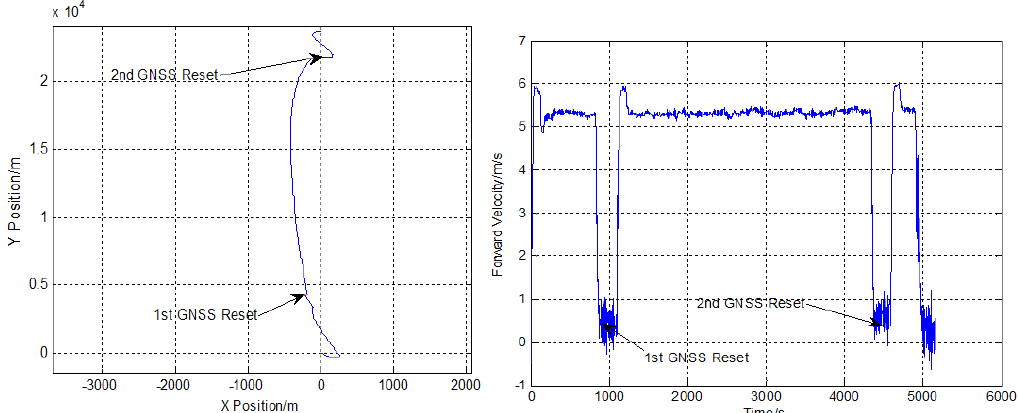
Figure 6. The trajectory and forward velocity of the AUV in Experiment 1.